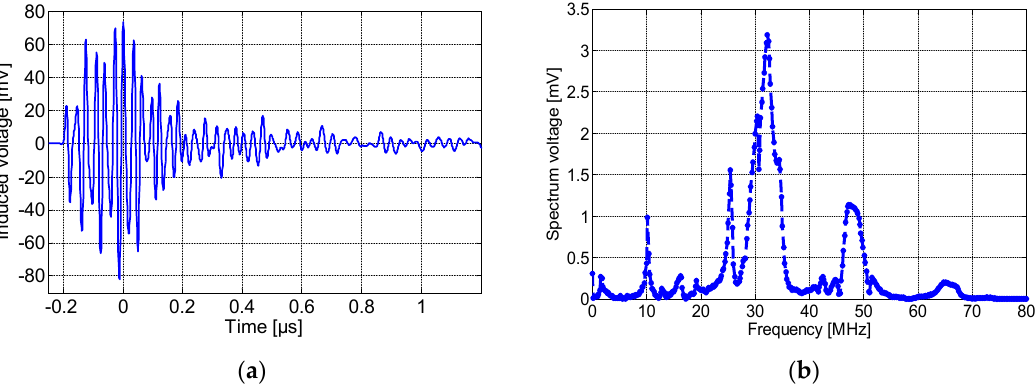
Figure 11. ( a ) The time-domain wave due to the partial discharge at 8.2 kV and ( b ) its frequency spectrum, detected by the meander sensor placed on